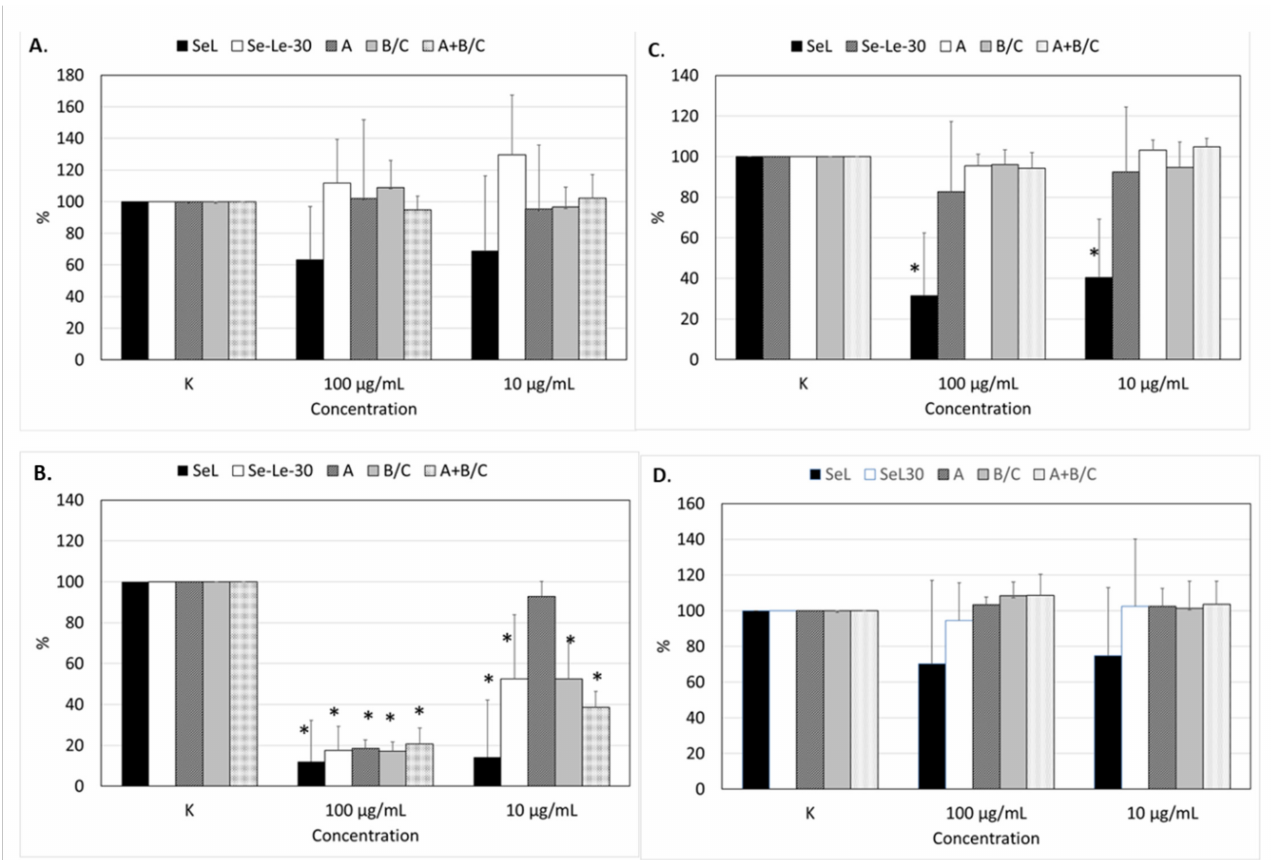
Figure 6. The effects of polysaccharides ( Se - L , Se-Le-30 , A , B - C , and A/B-C) on the proliferation of peripheral blood mononuclear cells (PBMCs). ( A ) Non-stimulated (autostimulation). ( B ) Stimulated with anti-CD3 monoclonal antibody (OKT3). ( C ) Stimulated with phytohemagglutinin (PHA). ( D ) Stimulated with the suspension of Staphylococcus aureus Cowan strain (SAC). The results are presented as the percentage of control (without polysaccharides) proliferation. * p < 0.05 versus control (K). The error bars correspond to the standard deviation. The results for the Se - L fraction were described by Kaleta et al. (2019)